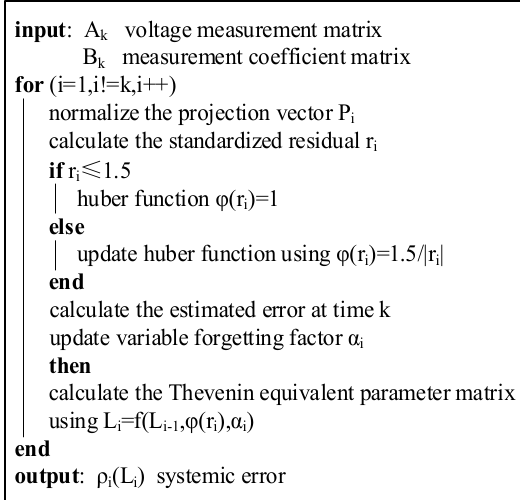
Figure 2. Pseudo code of HU-PS.